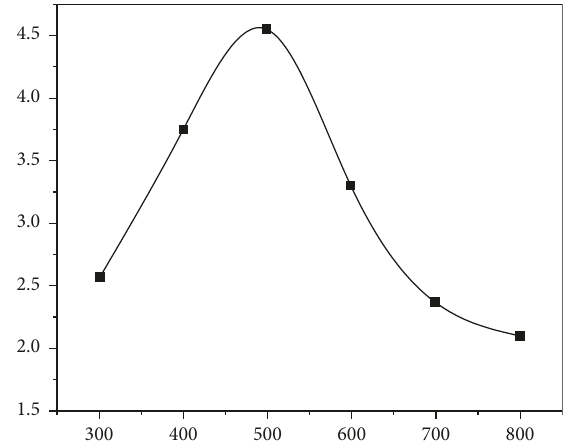
Figure 11: Line chart of actual data of visual clarity and brightness.